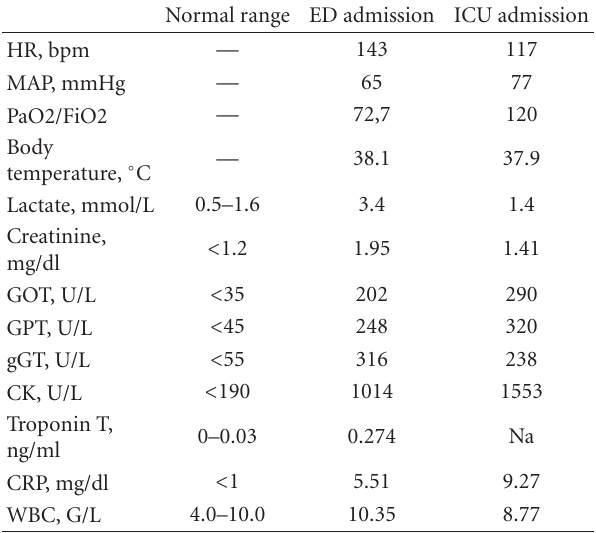
Table 1: Clinical and laboratory data on admission to the ED as well as to the